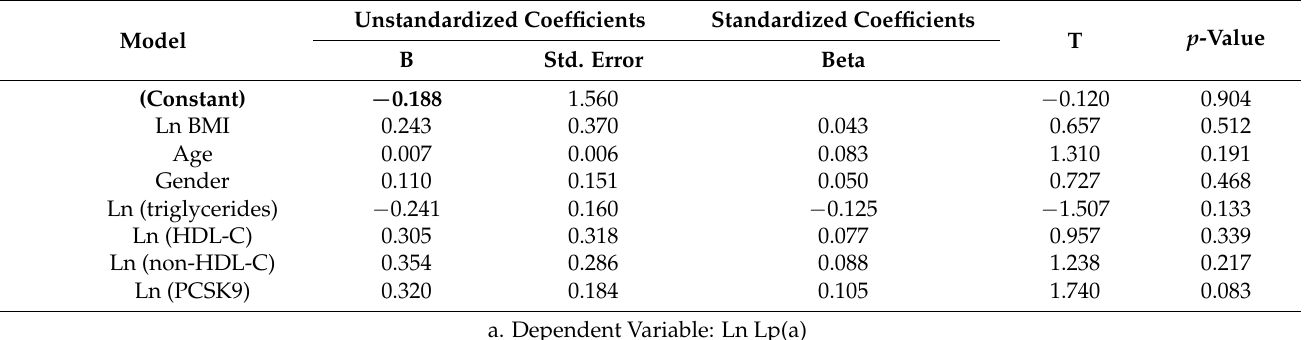
Table 4. Multiple linear regression analysis with lipoprotein a (Lp(a)) as a dependent variable